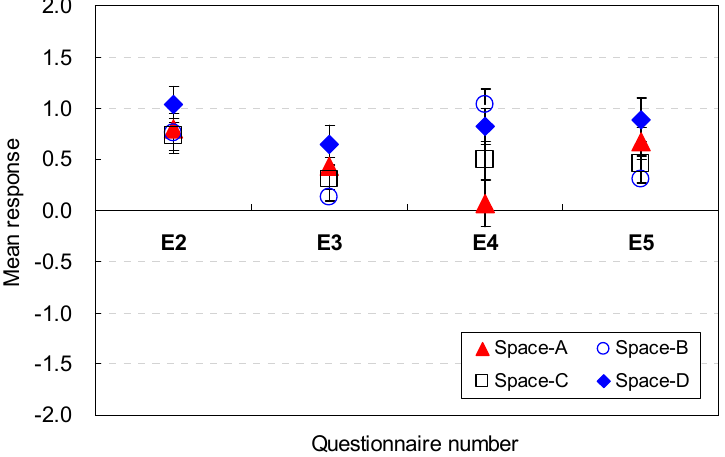
Figure 12. Spatial perception of the spatial size in terms of efficiency under height changes.